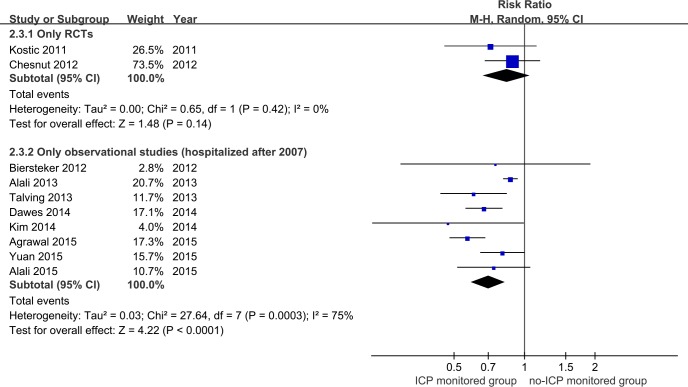
Forest plot of association between ICP monitoring and mortality in only RCTs, observational studies, and child populations.